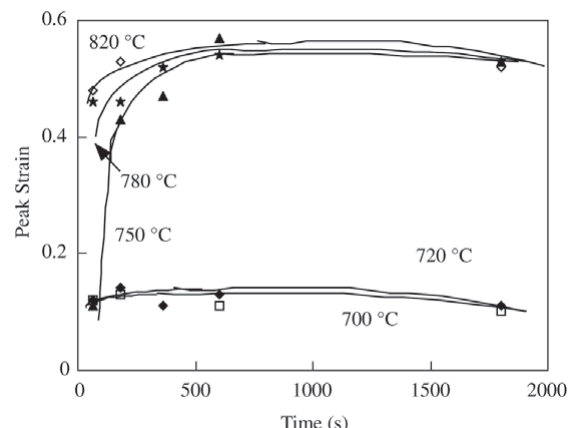
Figure 5. Dependence of the peak strain on the holding time be- fore